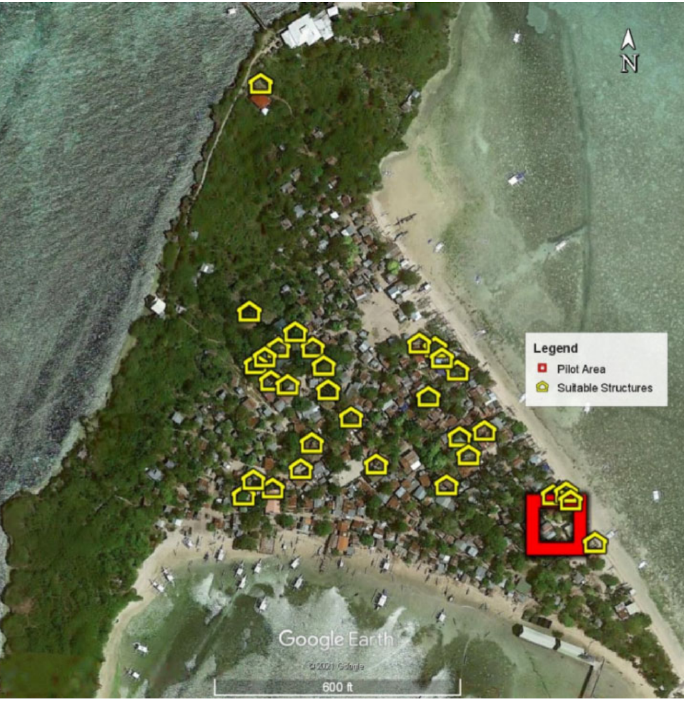
Figure 8. Location of the 31 structures on Gilutongan Island that were found to be suitable for rooftop solar PV installation.